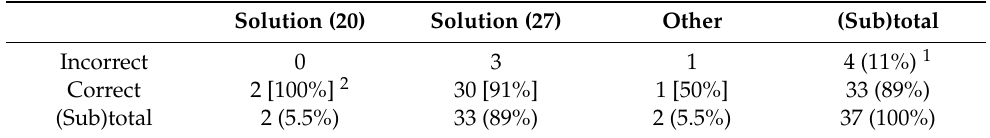
Table 4. Summary of solving the first-order linear ODE in the assignment in